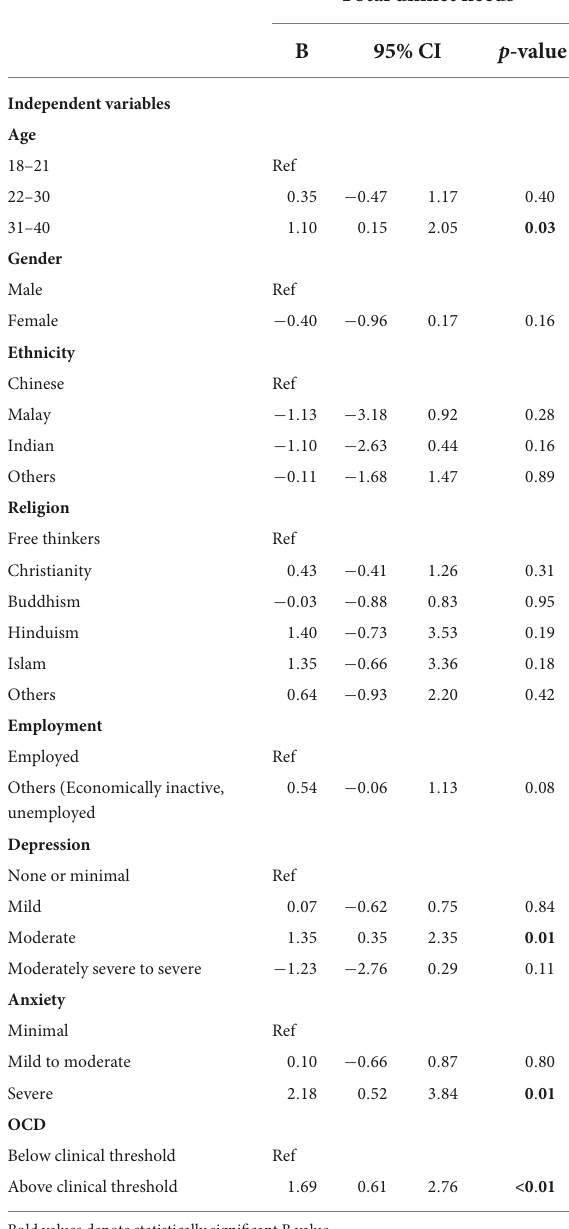
TABLE 3 Results of linear regression examining the sociodemographic and clinical correlates of needs felt by